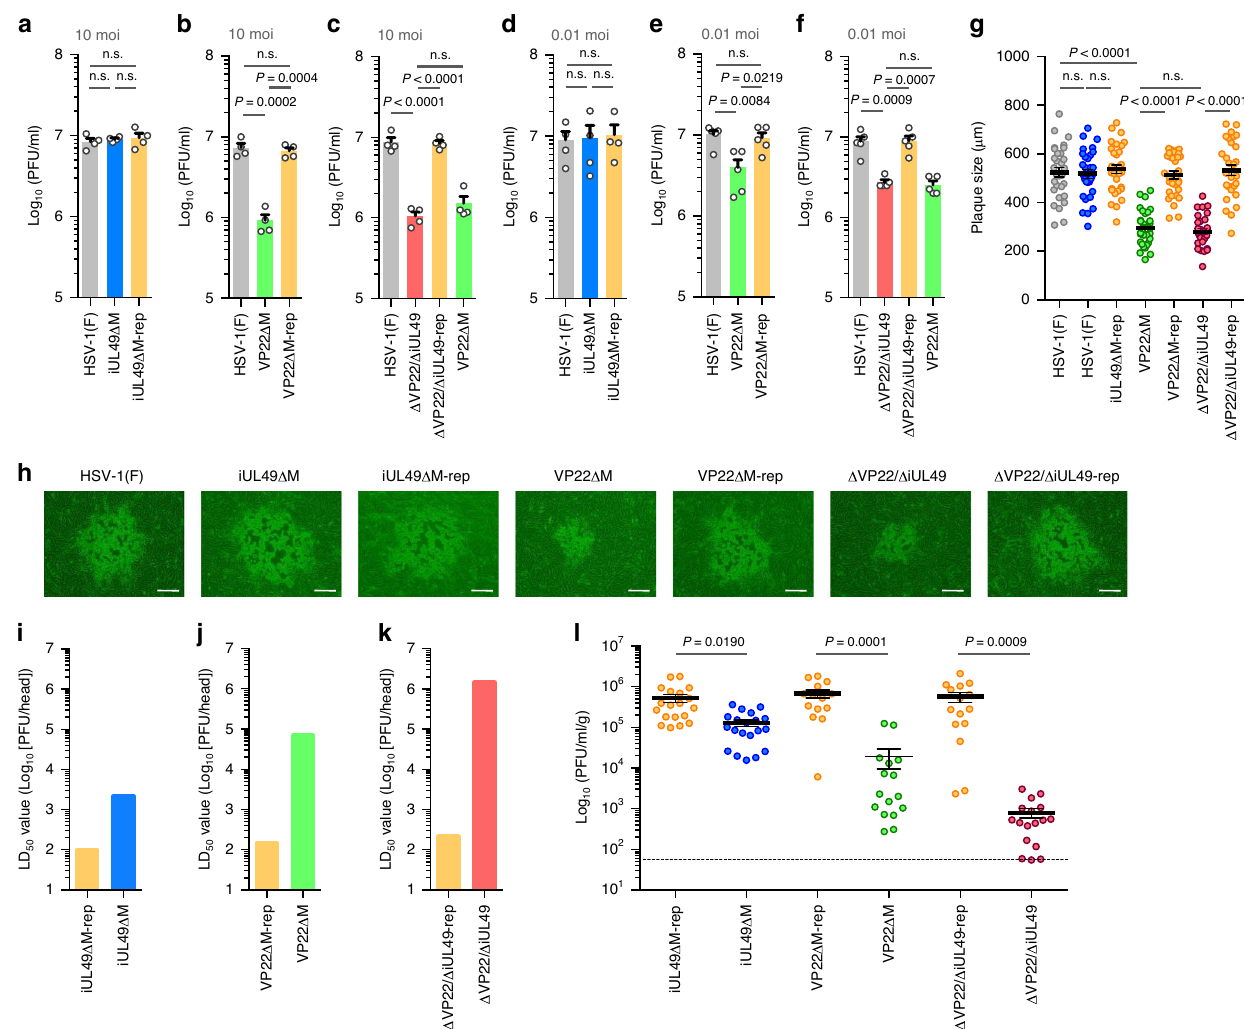
Fig. 3 piUL49 is an HSV-1 virulence factor. a – f Vero cells were infected with wild-type HSV-1(F) ( a – f ), iUL49 Δ M ( a , d ), iUL49 Δ M-rep ( a , d ), VP22 Δ M ( b , c , e , f ), VP22 Δ M-rep ( b , c , e , f ), Δ VP22/ Δ iUL49 ( c , f ), or Δ VP22/ Δ iUL49-rep ( c , f ) at an MOI of 10 ( a – c ) or 0.01 ( d – f ). Total virus titers in cell culture supernatants and infected cells at 21 ( a – c ) or 48 h ( d – f ) post-infection were assayed. Each value is the mean ± SEM of 4 ( a – c ) or 5 ( b – f ) independent